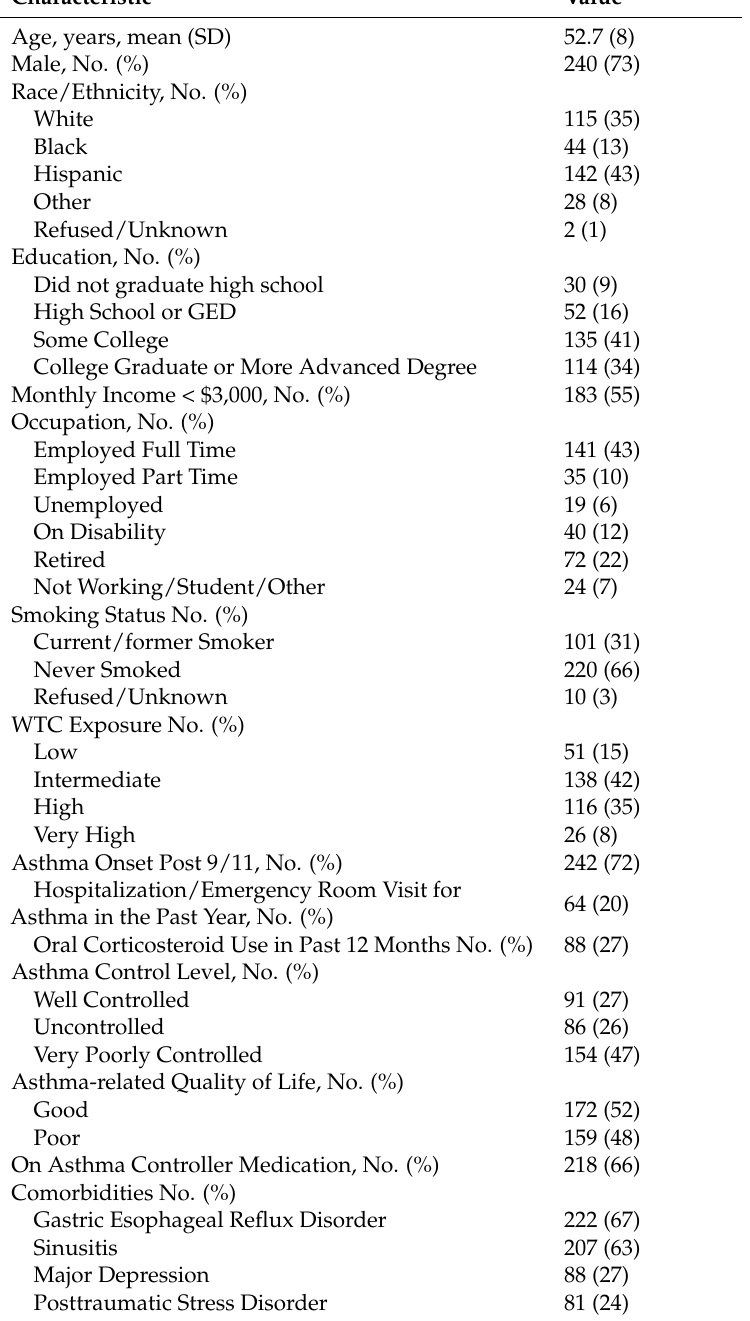
Table 1. Baseline characteristics of World Trade Center rescue and recovery workers with asthma.